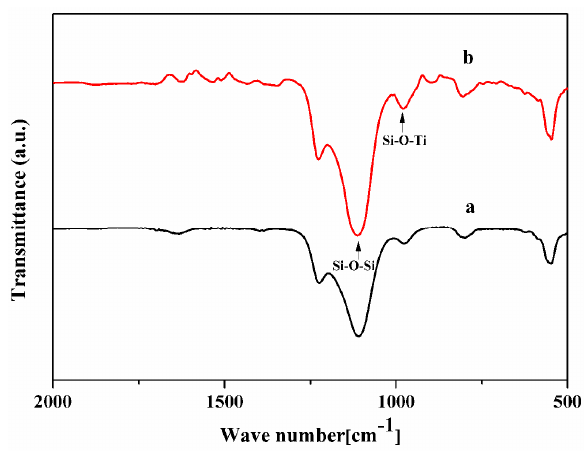
Figure 4. FT-IR spectra of the accompanying TS-1 zeolites: ( a ) S-2; ( b ) S-3. Table 3. Amount of the support, seeded support, and final membrane M-3.